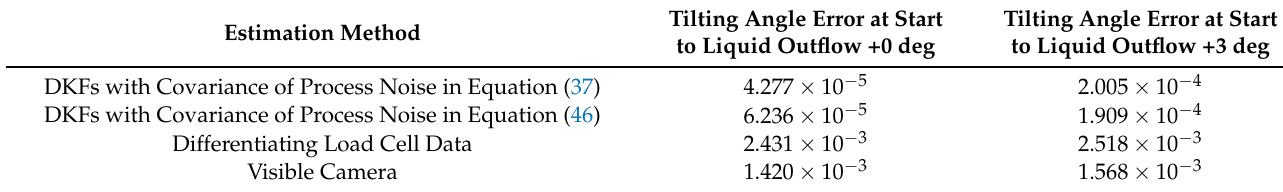
Table 1. Integral absolute errors (IAEs) between estimated flow rates and simulated flow rates.